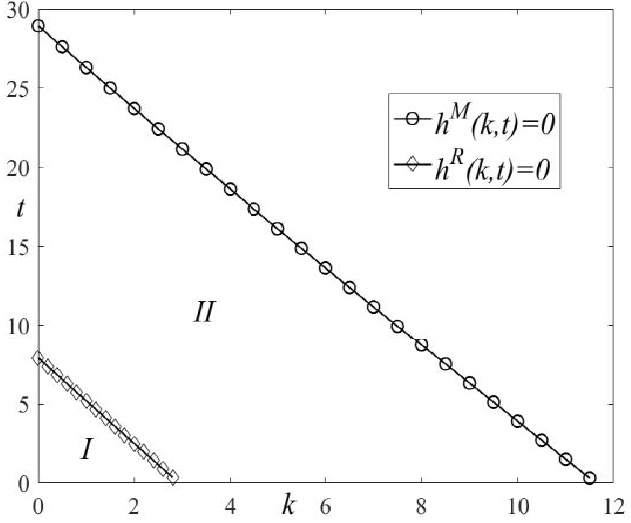
Figure 5. The LCT Figure 5. The LCT interval. Figure 5. The LCT interval.